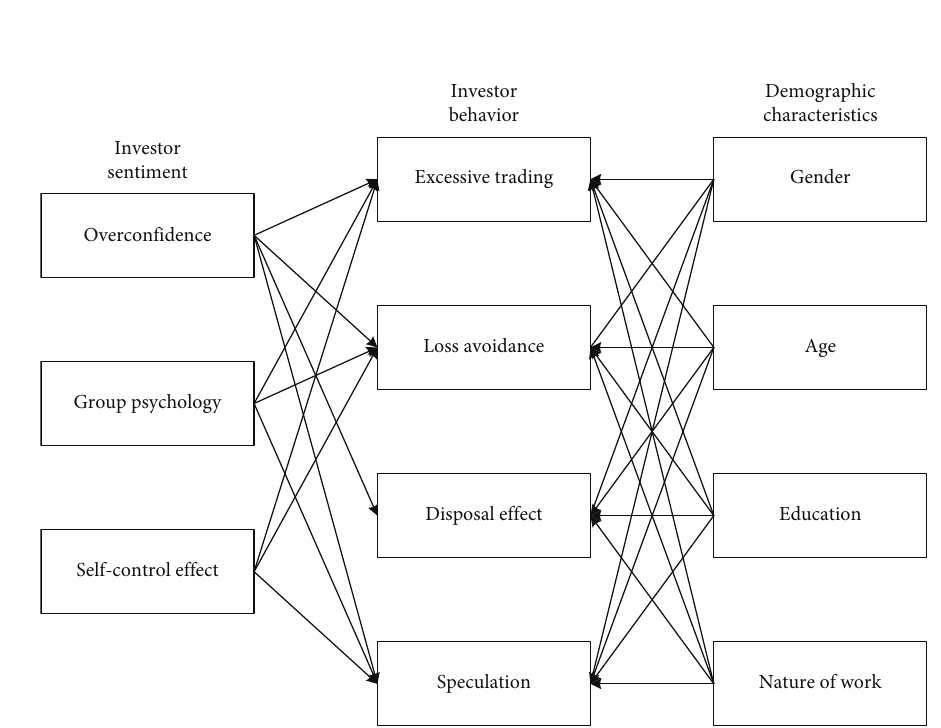
Figure 9: Structure of questionnaire evaluation